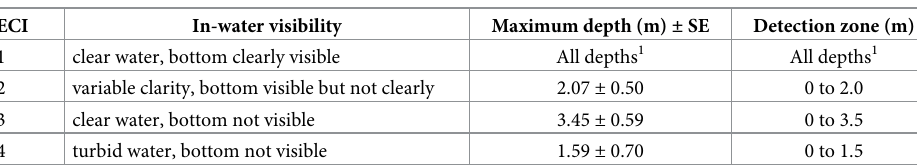
variable clarity, bottom visible but not clearly